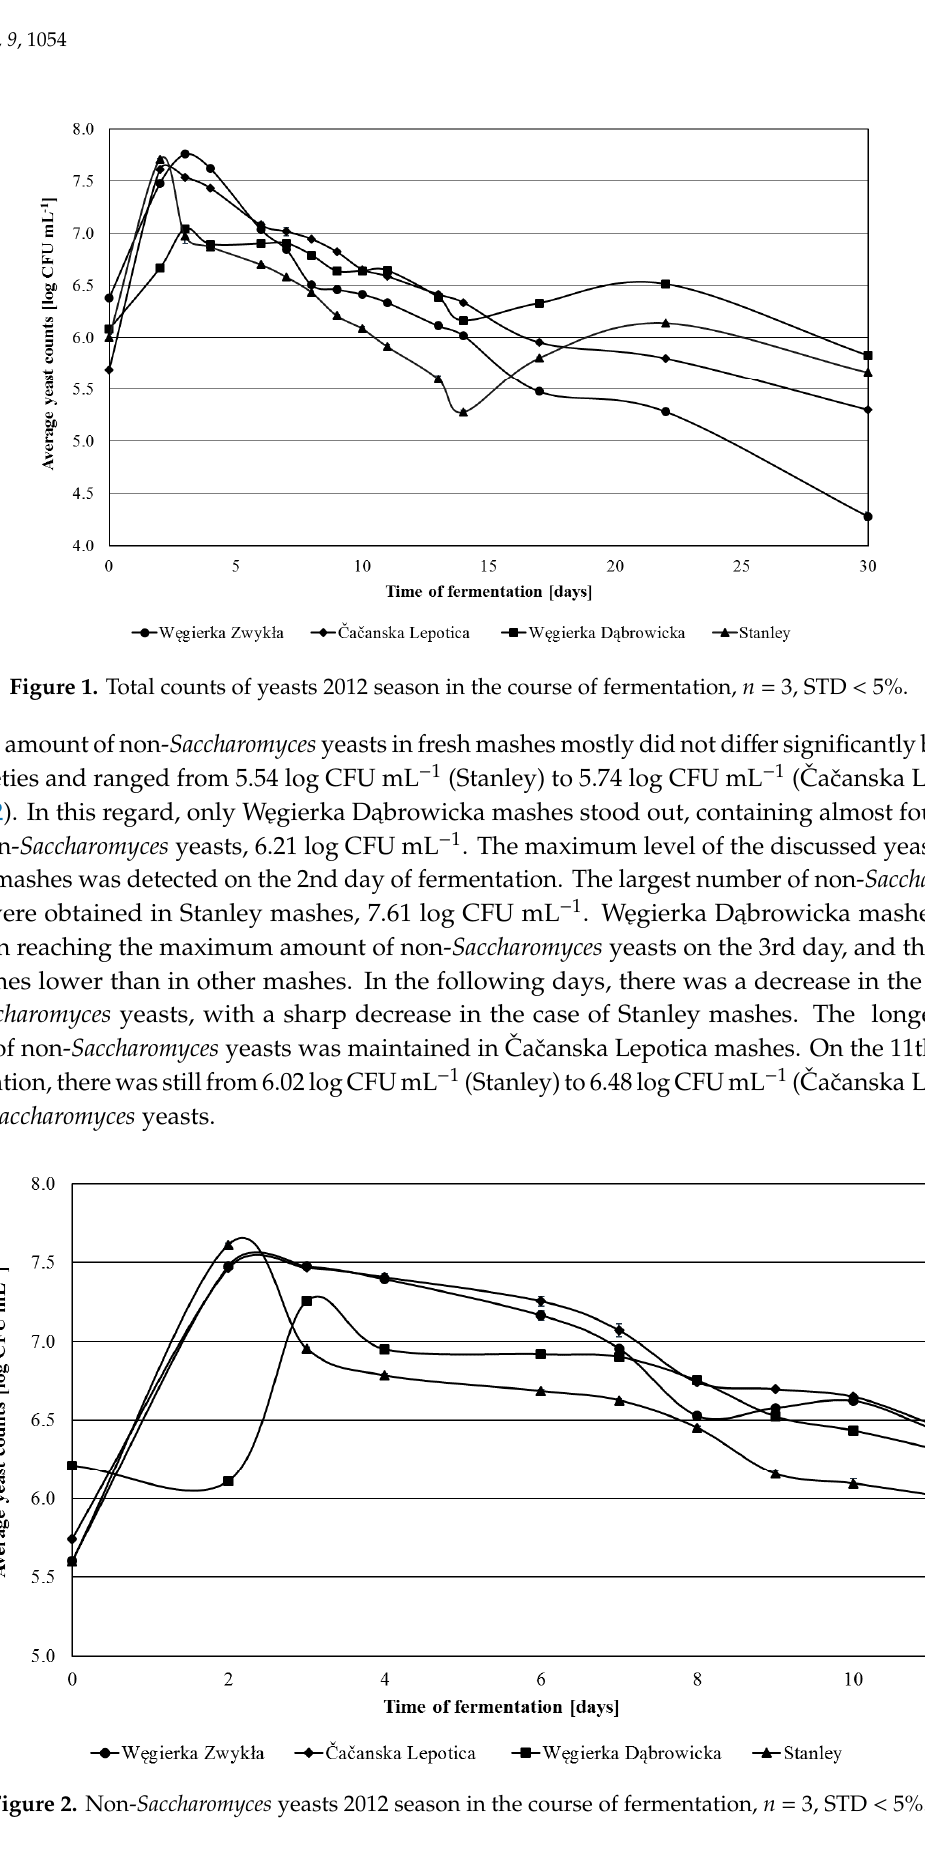
Figure 2. Non- Saccharomyces yeasts 2012 season in the course of fermentation, n = 3, STD < 5%.